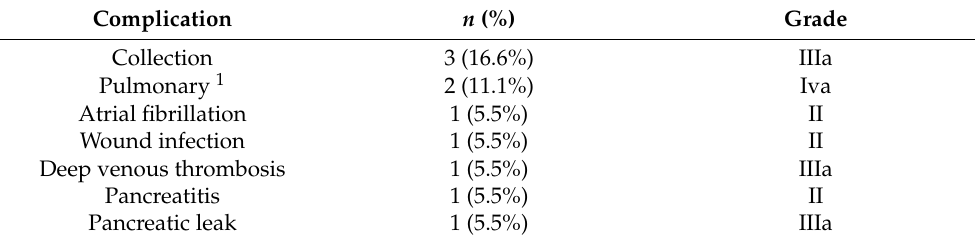
Table 3. Postoperative complications according to the Clavien-Dindo Classification